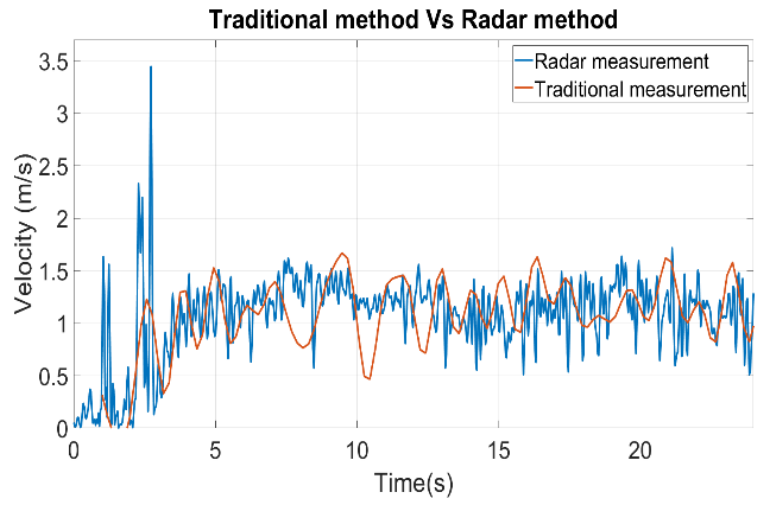
Figure 7. Trial 2, traditional measurement result plot vs. radar measurement result plot.